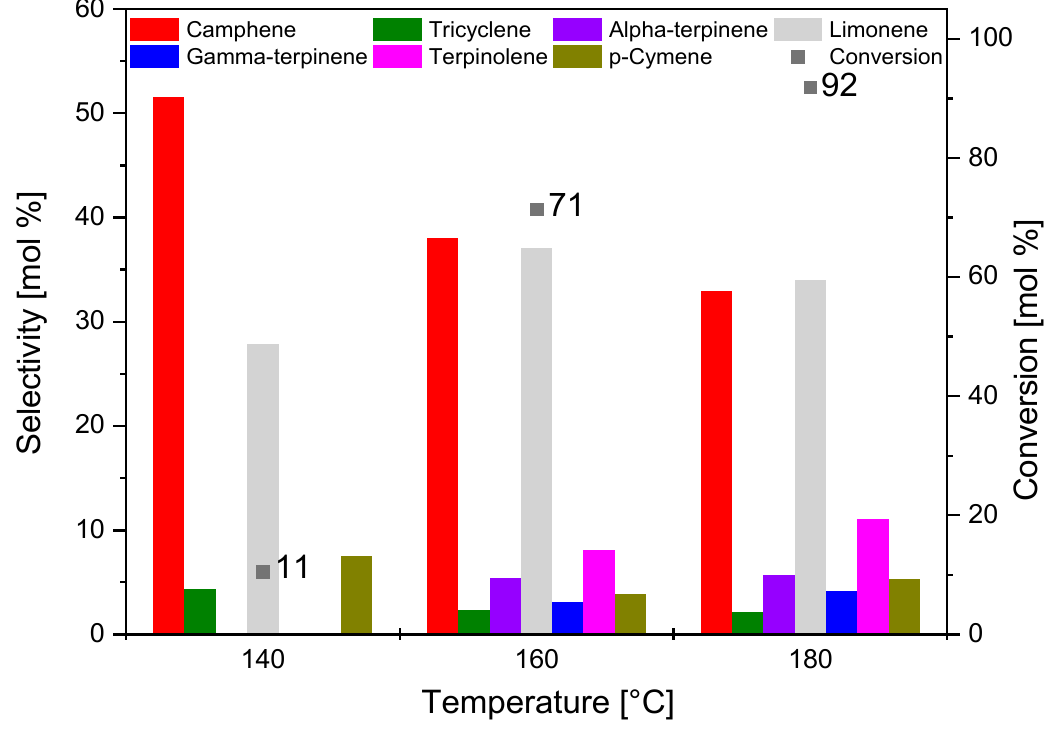
Figure 11. Comparison of the selectivity of the main products and the conversion of organic raw material (alpha-pinene) at different temperatures after 3 h for the C_AC sample.